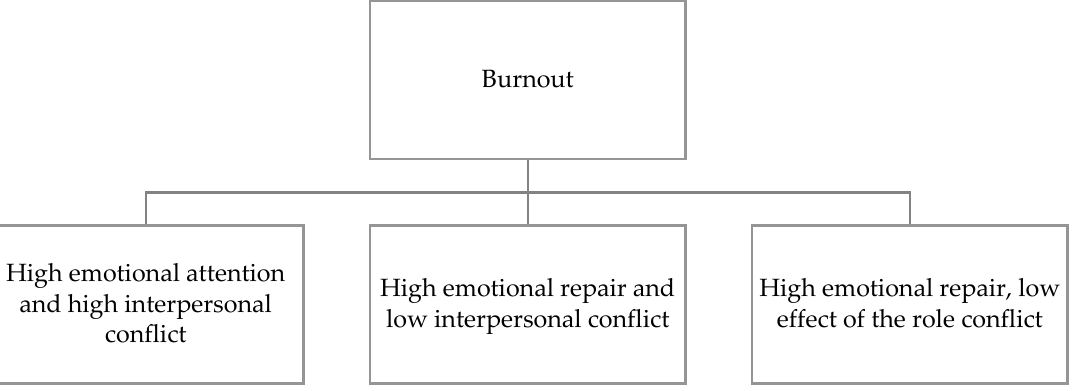
Figure 1. Moderation of emotional intelligence on the e ff ect of psychosocial risks on burnout.